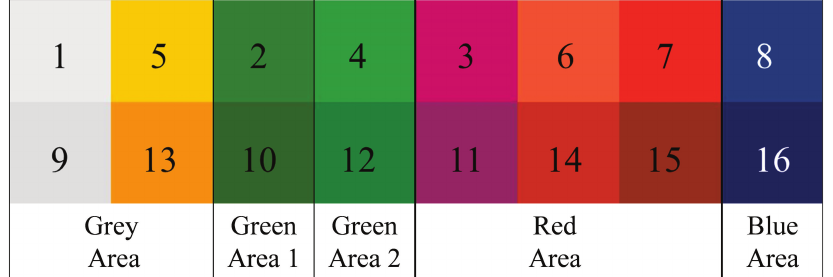
Figure 3. The illustration of the pseudo-color